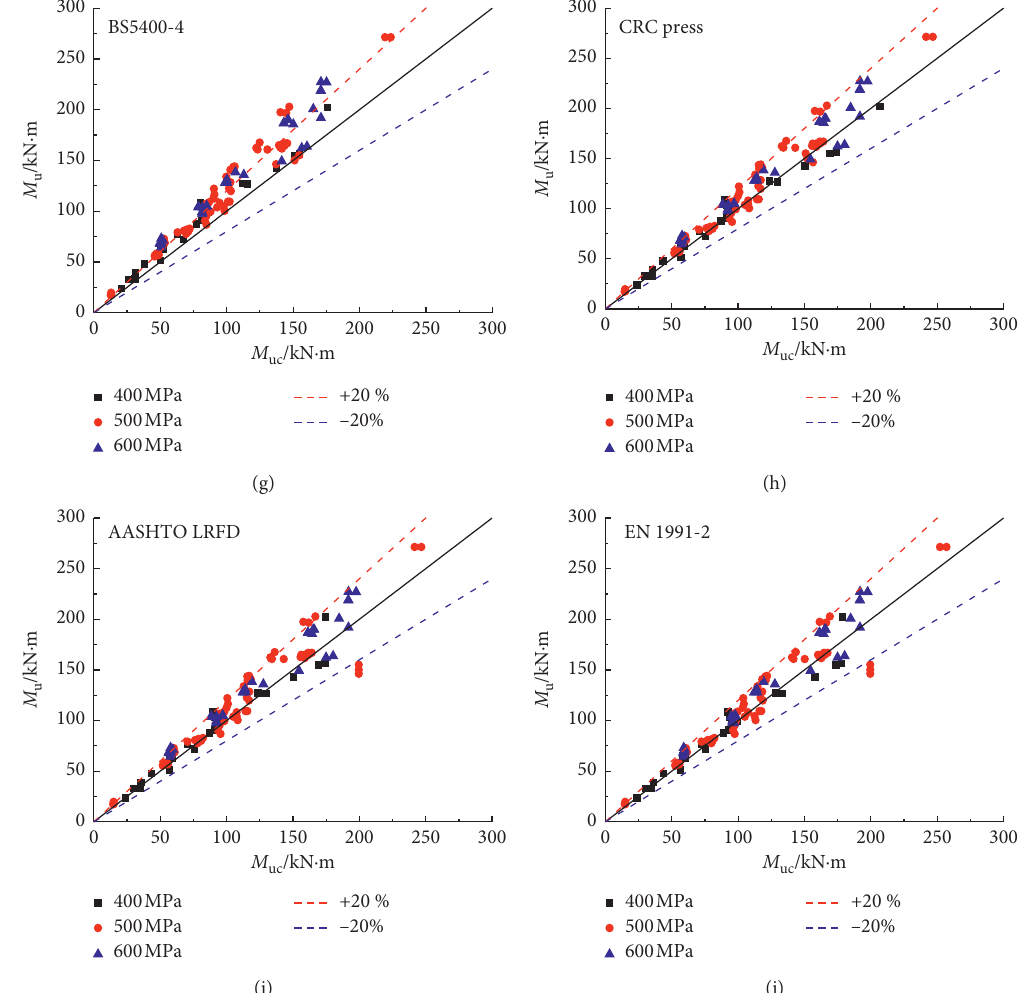
Figure 8: Comparison of experimental flexural bearing capacity M